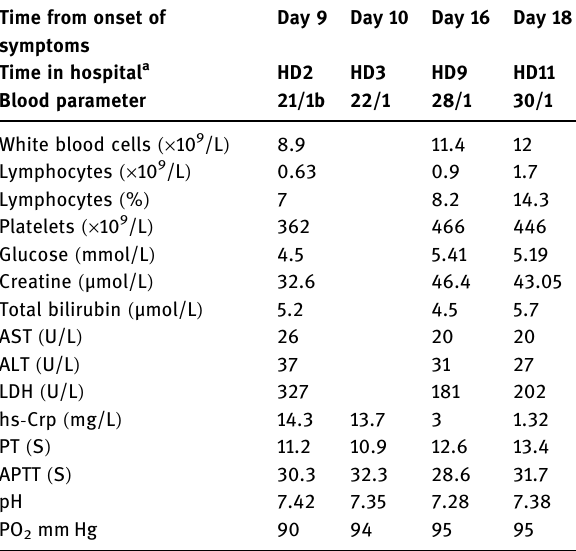
a Number of days from admission to hospital. b Calendar